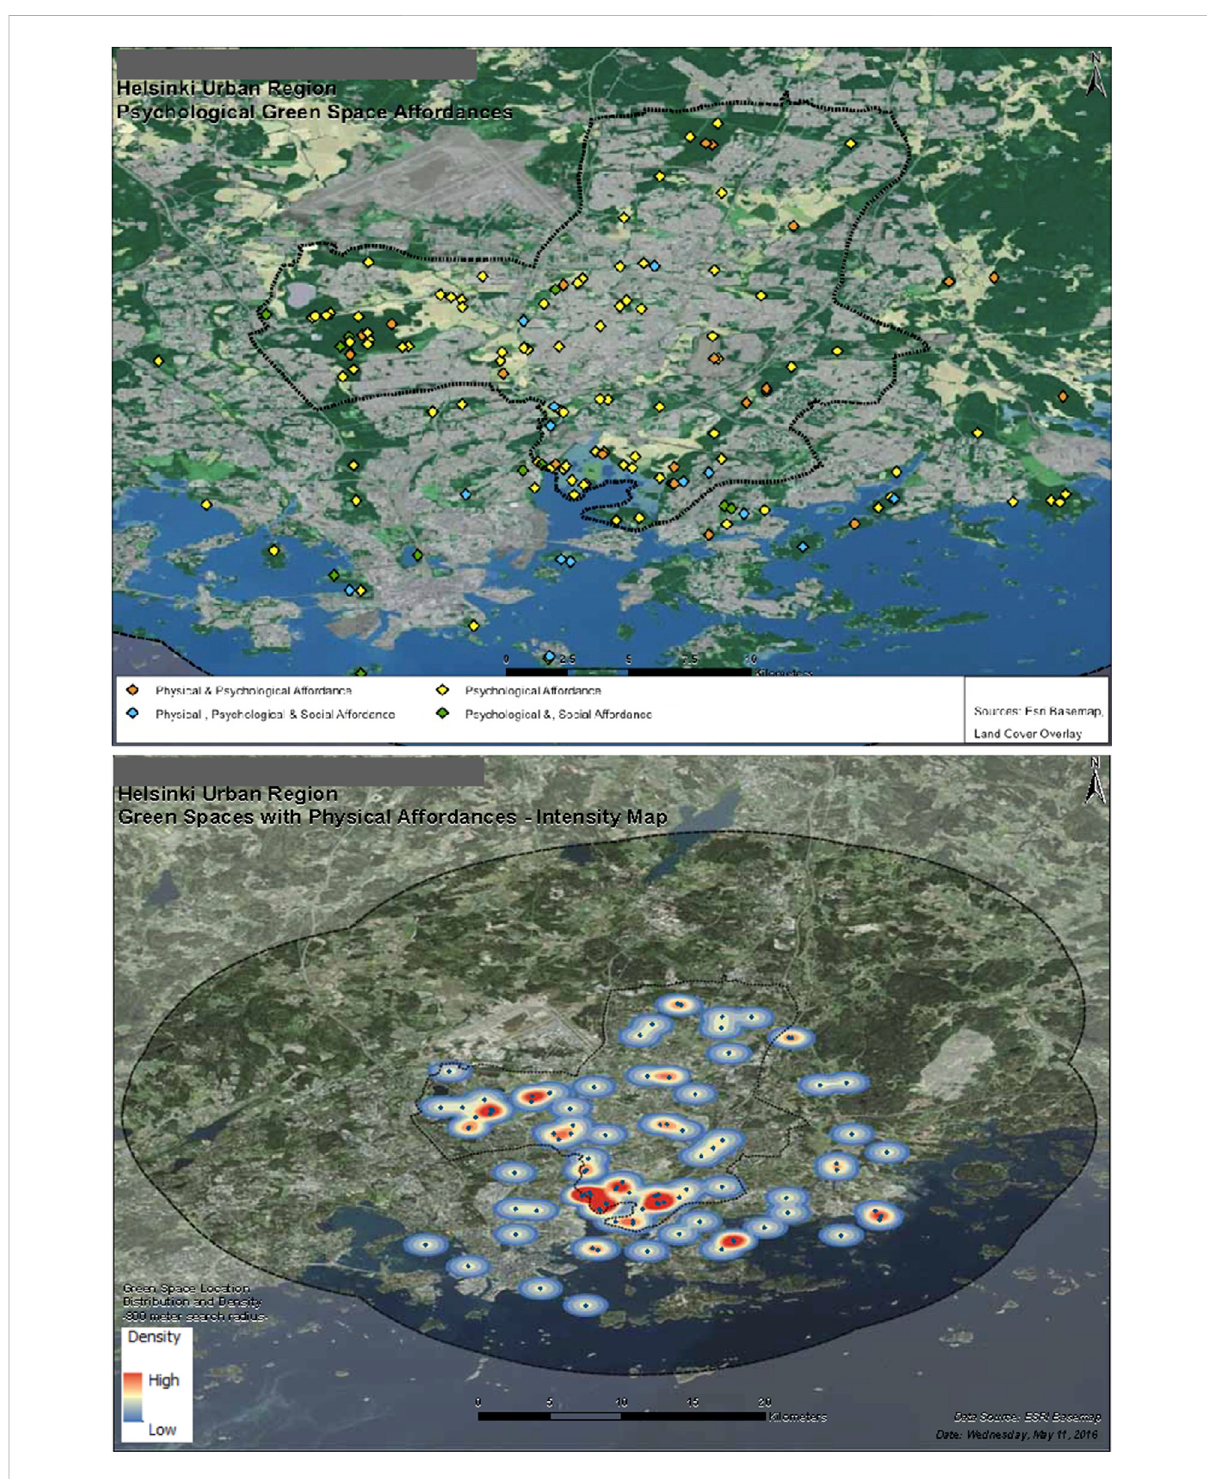
FIGURE 5 Psychological human wellbeing affordance locations and intensity map. Source: